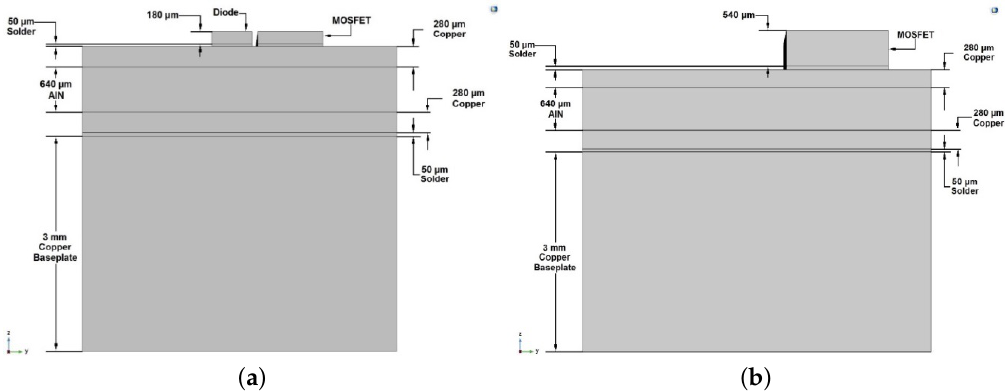
Figure 17. yz-plane view of MOSFET modules: ( a ) for Si; ( b ) for GaN.